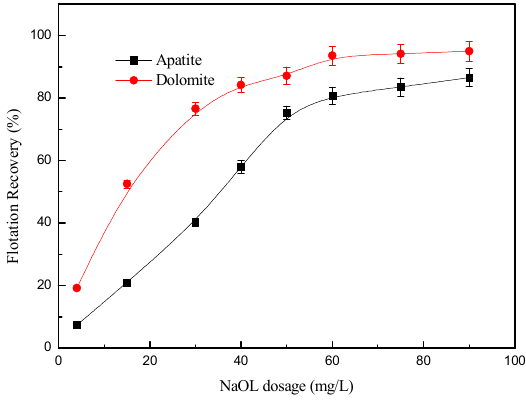
Figure 3. Effect of sodium oleate (NaOL) dosage on the flotation of apatite and dolomite.